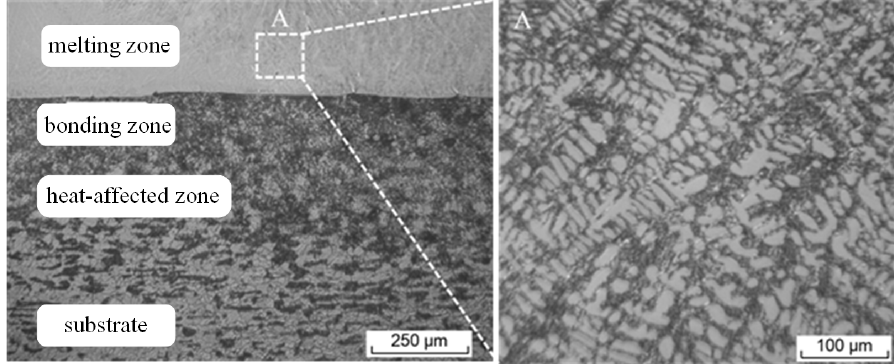
Figure 1. The cross-sectional morphology of cladding layer: (A) partial enlargement of the cladding layer. that compounds of α -(Fe, Cr) solid solution and (Cr, Fe) 7 C 3 were generated in the cladding layer at the position of 2 θ = 44.53 ◦ , 64.55 ◦ , and 82.09 ◦ . Similar results were obtained by